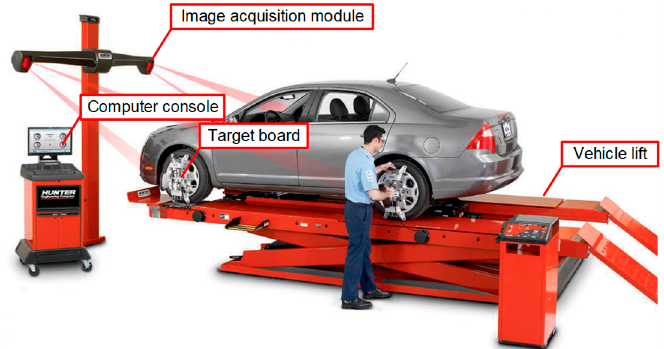
Figure 2. Overall structure of a typical wheel alignment inspection system for a full car [3].